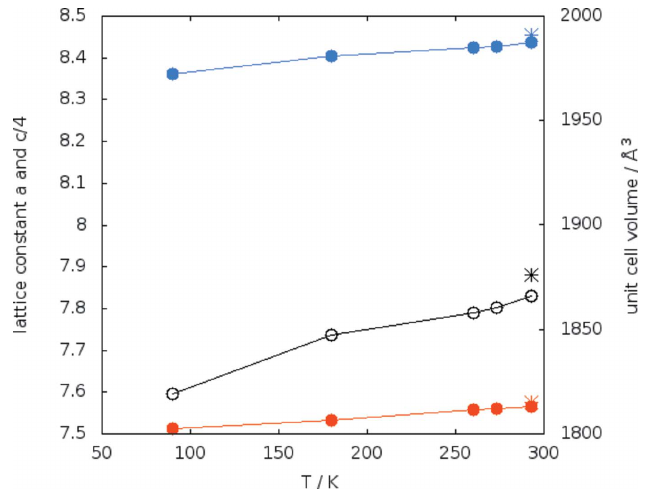
Figure 1 Variation of lattice parameters with temperature; a axis in red, c axis in blue, values divided by four, volume shown in black; circles: from single- crystal measurements, stars: data from powder X-ray measurement: a = 8.4552 (7) A˚ , c = 30.3032 (3) A˚ , V = 1876.18 A˚